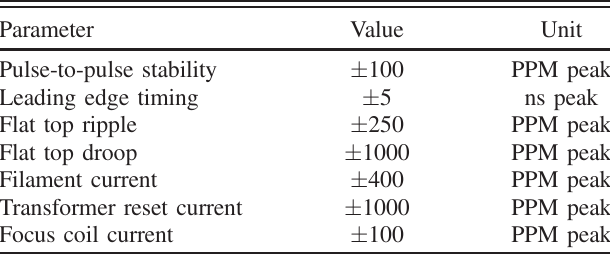
TABLE IX. Klystron modulator stability specifications. Pulse parameters are for klystron beam voltage or current over a five- minute